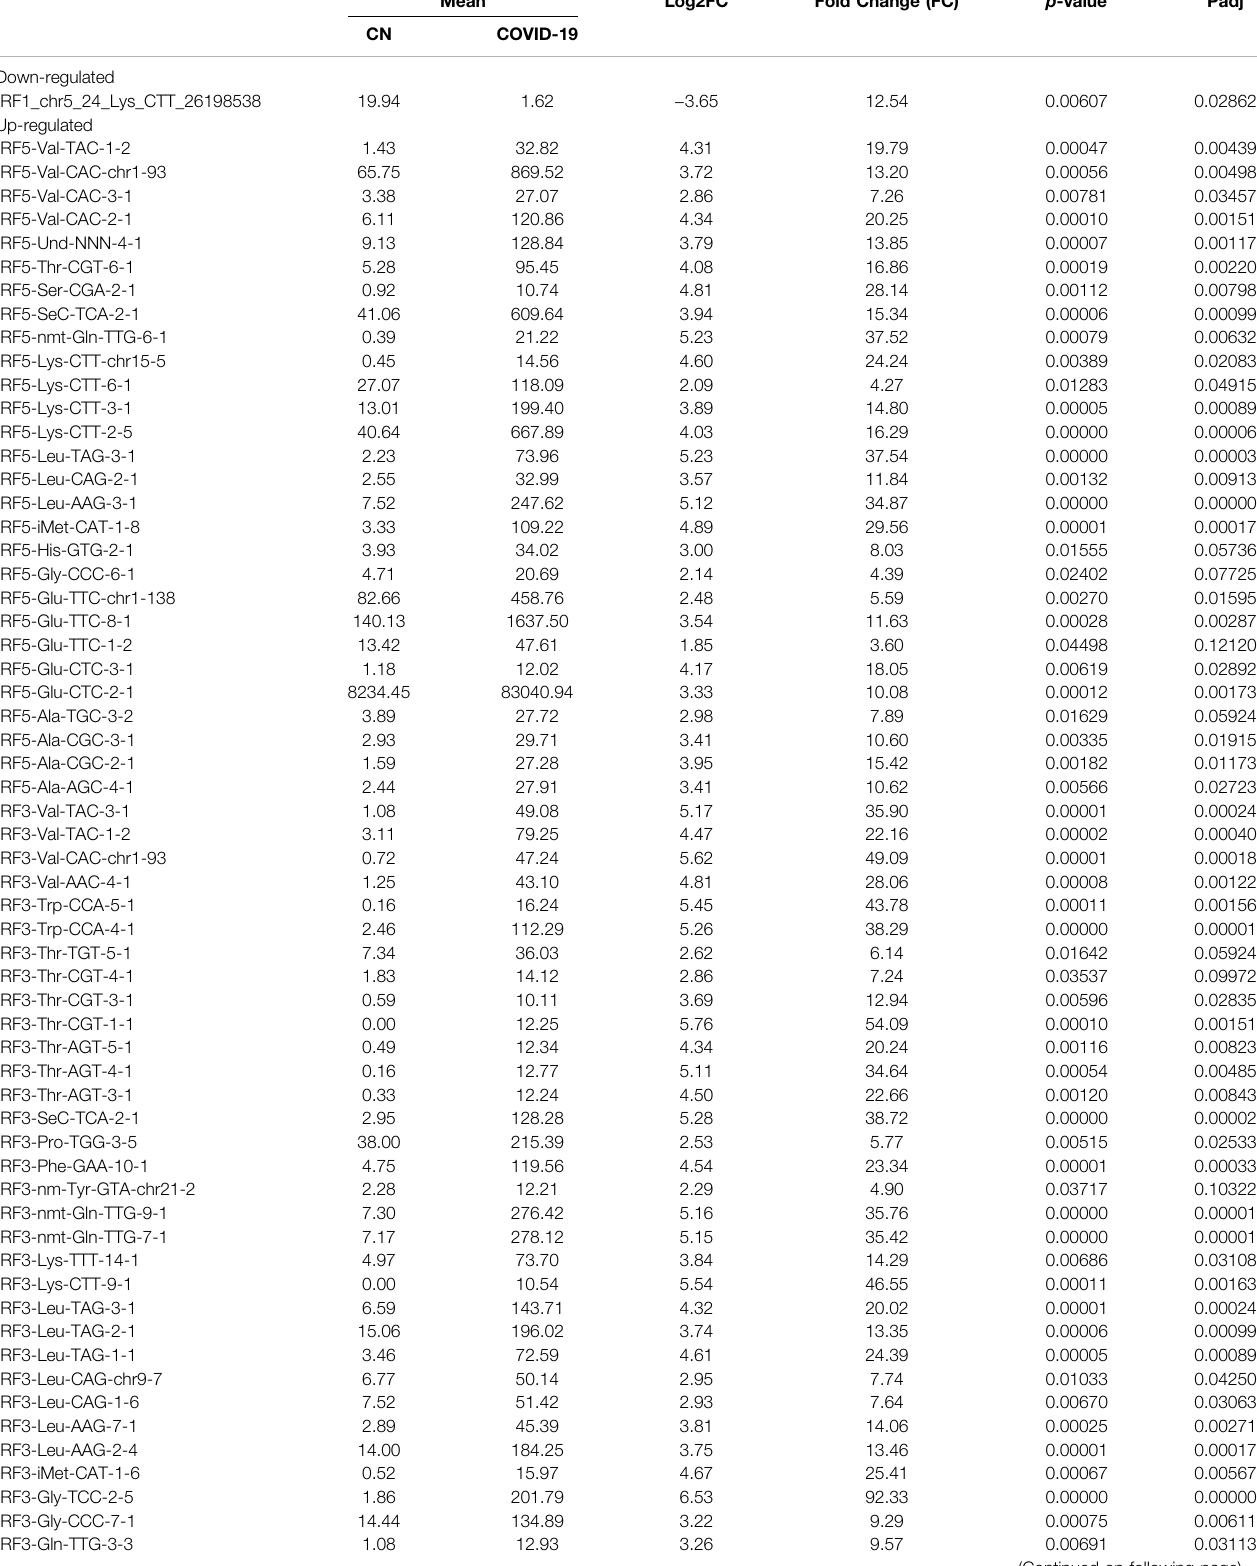
TABLE 2 | Changes in tRFs by SARS-CoV-2. Mean Log2FC Fold Change (FC) p -value Padj CN